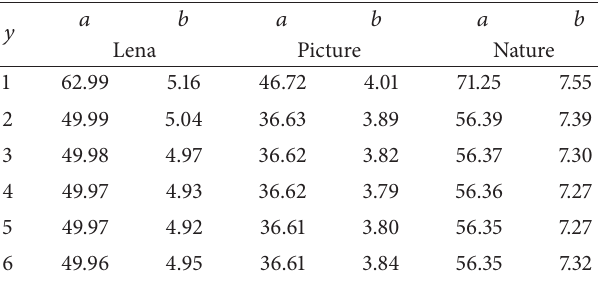
Table2:RMSEvaluesofthe radiusbyradius basicfunctioncreation.